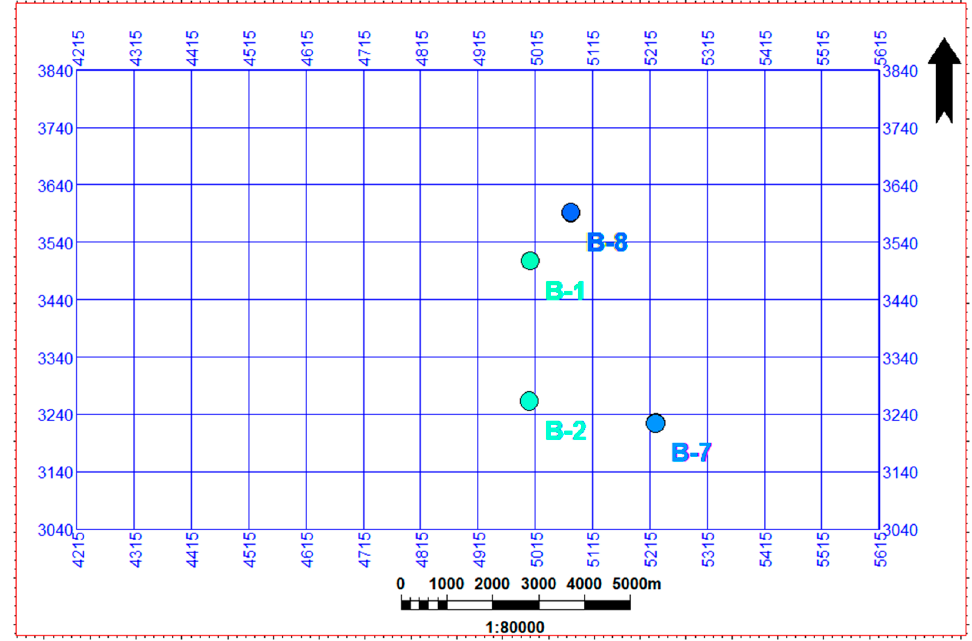
Figure 4. Seismic base map showing the well locations.